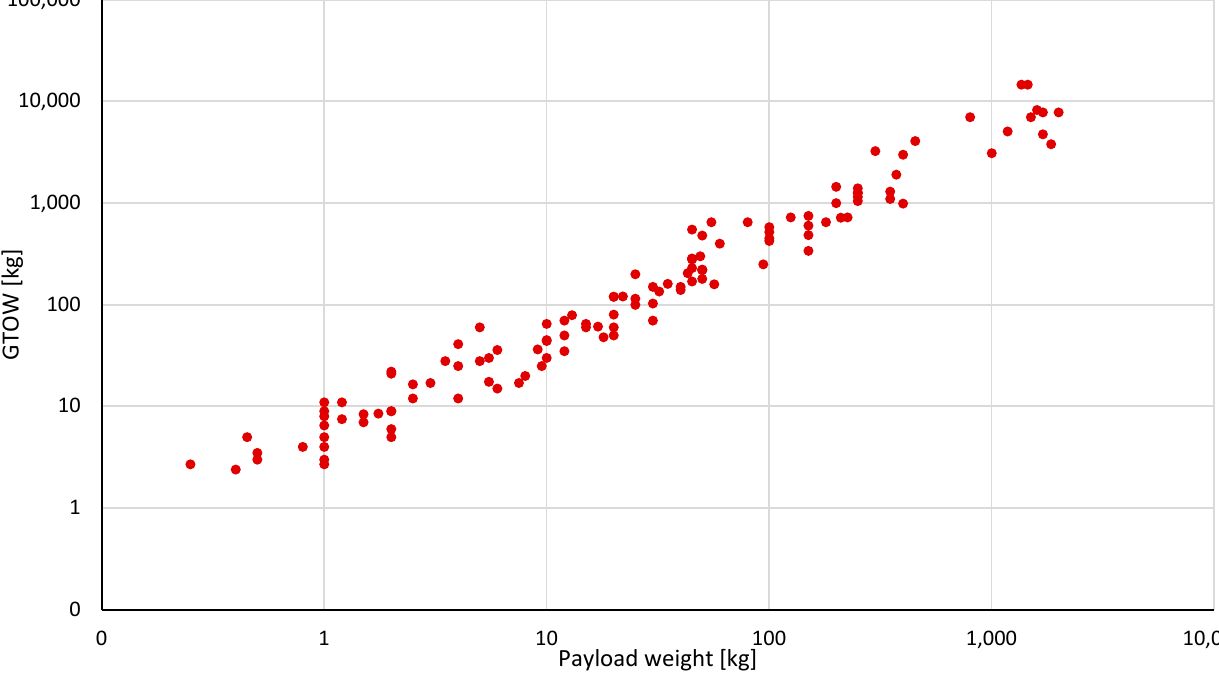
Figure 8. GTOW as a function of payload weight for the general category.